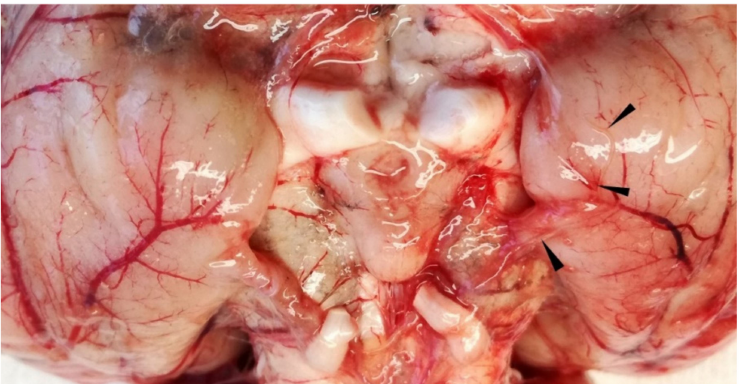
Figure 7. Wapiti, case 2, ventral side of brain, gross pathology. Severe subacute serofibrinous menin- gitis and thin nematode on surface of piriform lobe partially embedded in blood vessel (arrowheads).